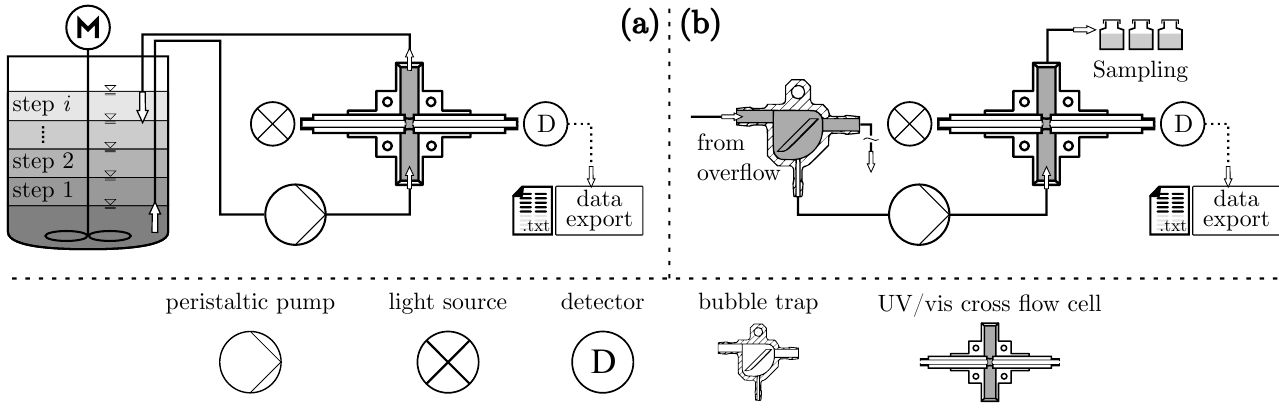
Figure 4. Illustration of the calibration setup ( a ) and the experimental setup ( b ) of the hardware sensor. Components are depicted and named in the bottom